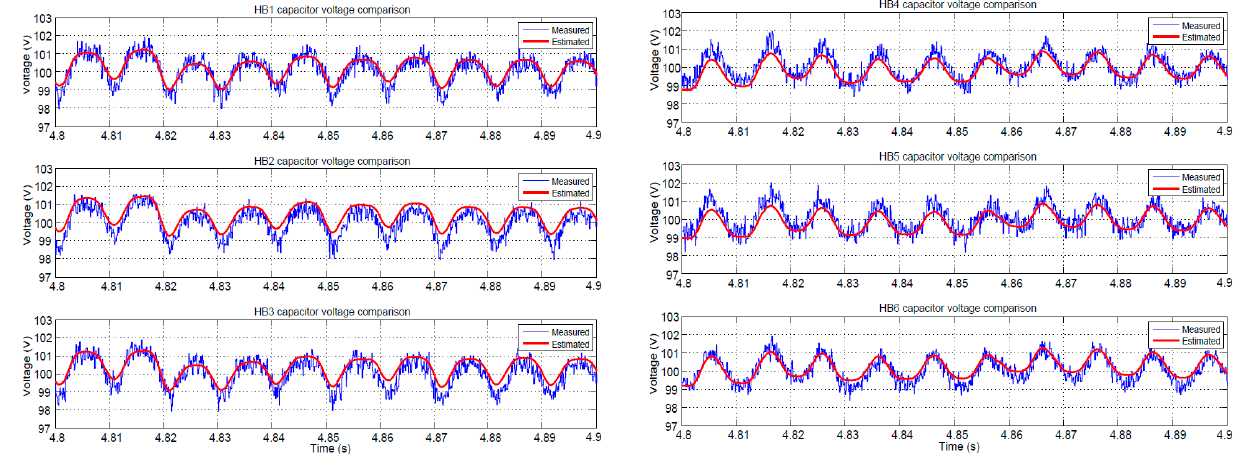
Figure 5. eRTS capacitor voltages estimations of the series (HB1–HB3) and derivation branch (HB4–HB6) during healthy mode.